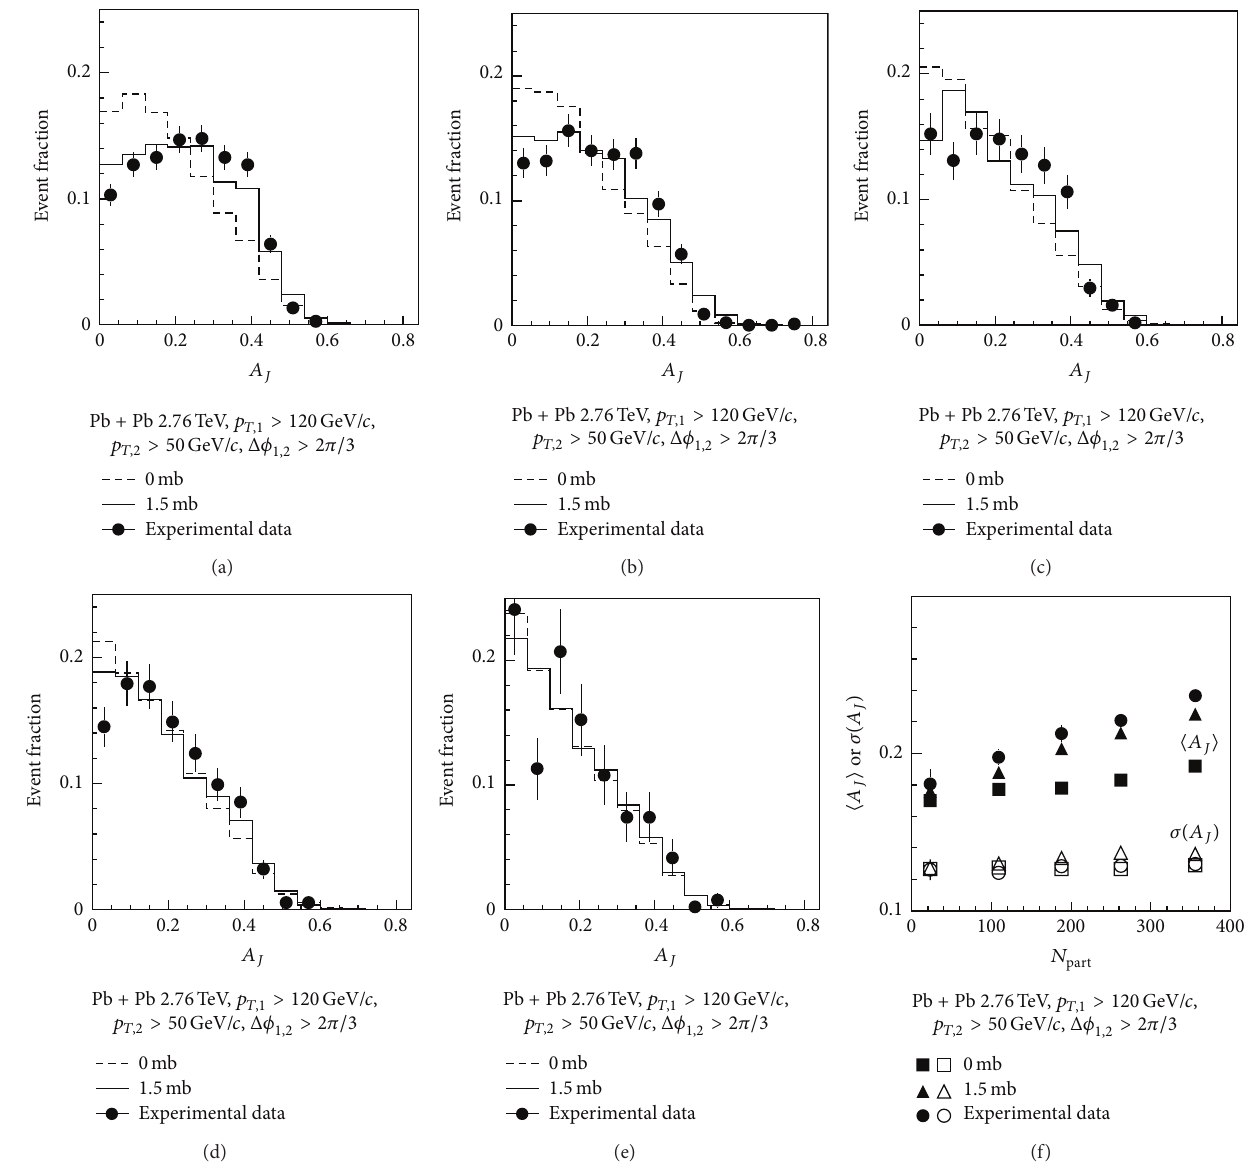
Figure 2: Dijet asymmetry ratio 𝐴 𝐽 distributions for leading jets of 𝑝 𝑇,2 > 120 GeV/c with subleading jets of 𝑝 𝑇,2 > 50 GeV/c and Δ𝜙 1,2 > 2𝜋/3 in Pb + Pb collisions at √𝑠 𝑁𝑁 = 2.76 TeV for five centrality bins: (a) 0–10%, (b) 10–20%, (c) 20–30%, (d) 30–50%, and (e) 50–100%, where the solid (1.5mb) and dash (0 mb) histograms represent the AMPT results with partonic + hadronic and hadronic interactions only, respectively, while the solid circles represent the data from the CMS experiment [10]. (f) The mean values and variances of 𝐴 𝐽 distributions as functions of 𝑁 part